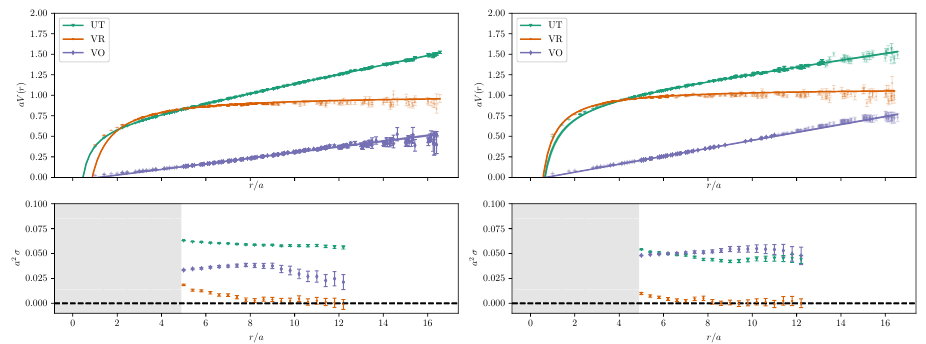
Figure 6. The static quark potential calculated on the vortex-modified pure-gauge (left) and m π = 156 MeV dynamical-fermion (right) ensembles. The lower plot shows the local slope from linear fits of the potentials in the upper plot over a forward-looking window from r to r + 4 a